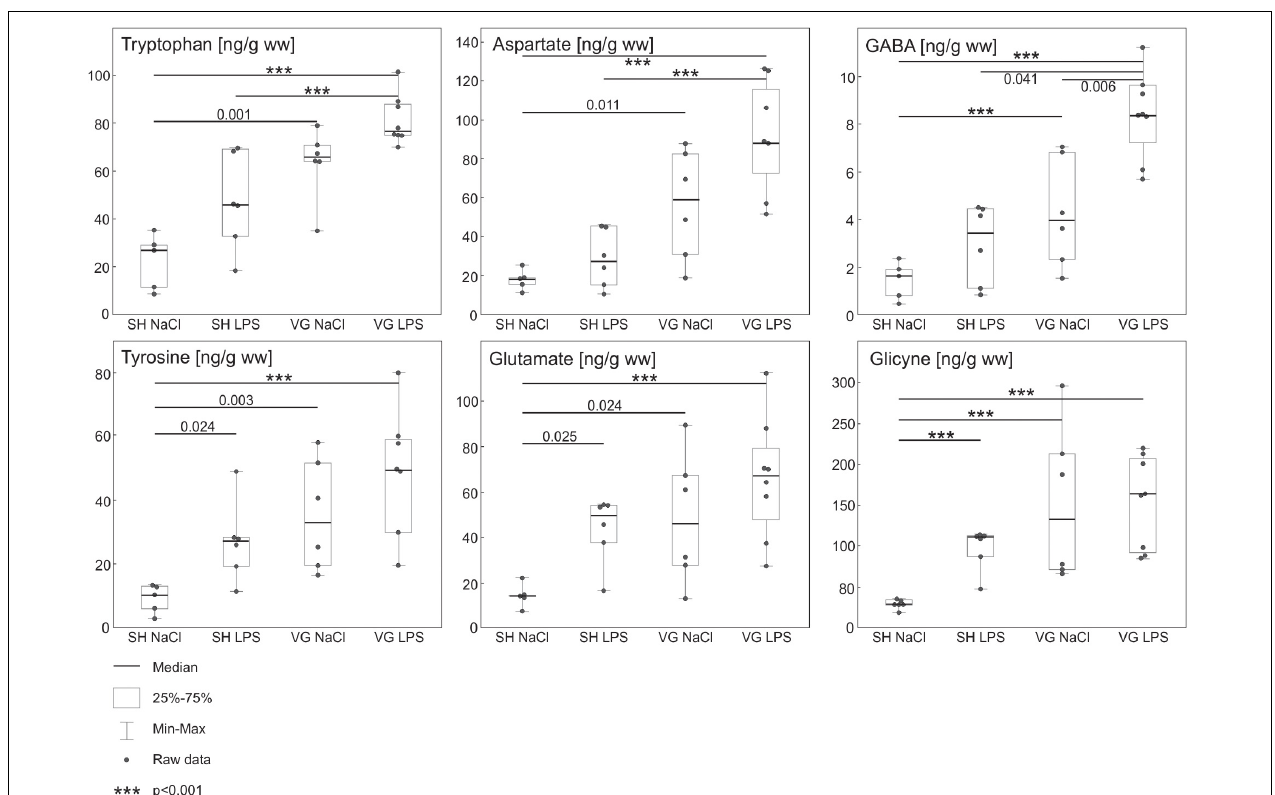
FIGURE 2 | Results of high performance liquid chromatography (HPLC) analysis of amino acids in hypothalamus. Concentrations of monoaminergic neurotransmitter precursors (Tyrosine, Tryptophan) and inhibitory amino acid neurotransmitters (GABA, Glycine) are increased in vagotomized group (VG NaCl vs. SH NaCl). Similar effect is absent in case of excitatory amino acid neurotransmitters (Glutamate, Aspartate). During intraperitoneal inflammation changes in tyrosine and tryptophan concentrations in vagotomized group (VG LPS vs. SH LPS) are even more pronounced. Additionally, we observe a significant increase of inhibitory GABA and excitatory aspartate concentration in that group (VG LPS vs. SH LPS). Details in